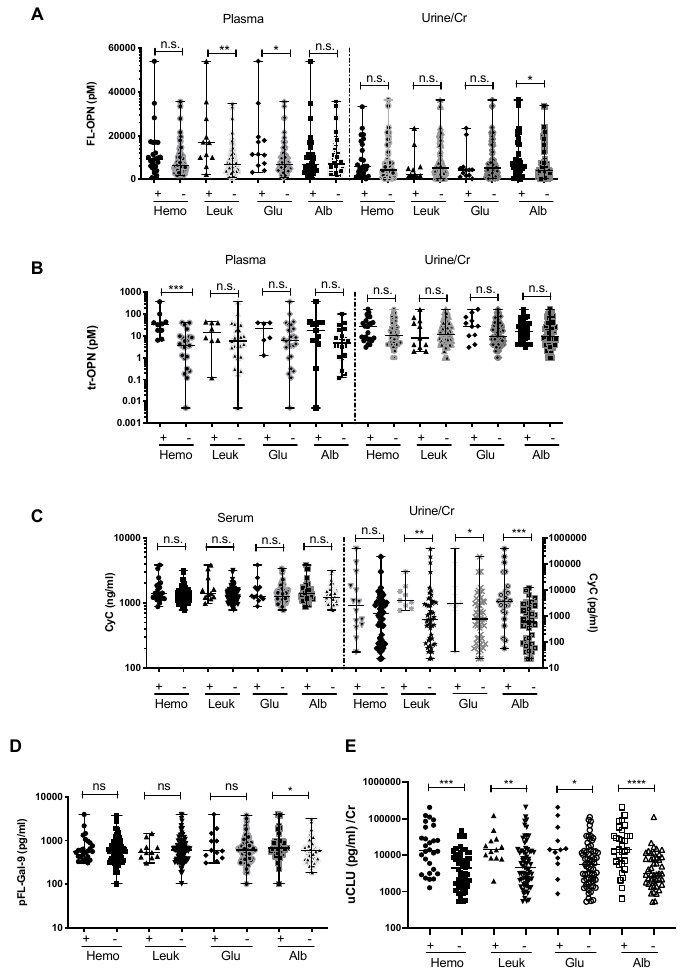
Figure 3. Plasma and urinary markers of FL-OPN ( A ), tr-OPN ( B ), Cyc ( C ), plasma pFL-Gal-9 ( D ), and uCLU / Cr ( E ) in hematuria (Hemo)-, leukocyte (Leuk)-, glucose (Glu)-, and albumin (Alb)-positive or -negative groups among leptospirosis patients. p value is written as: ns, no significant; * p < 0.05, ** p < 0.01, *** p < 0.001, **** p < 0.0001. FL-OPN, full length of osteopontin; tr-OPN, thrombin –cleaved osteopontin; CyC, cystatin C; FL-Gal-9, full length of galectin-9; CLU, clusterin; Cr,